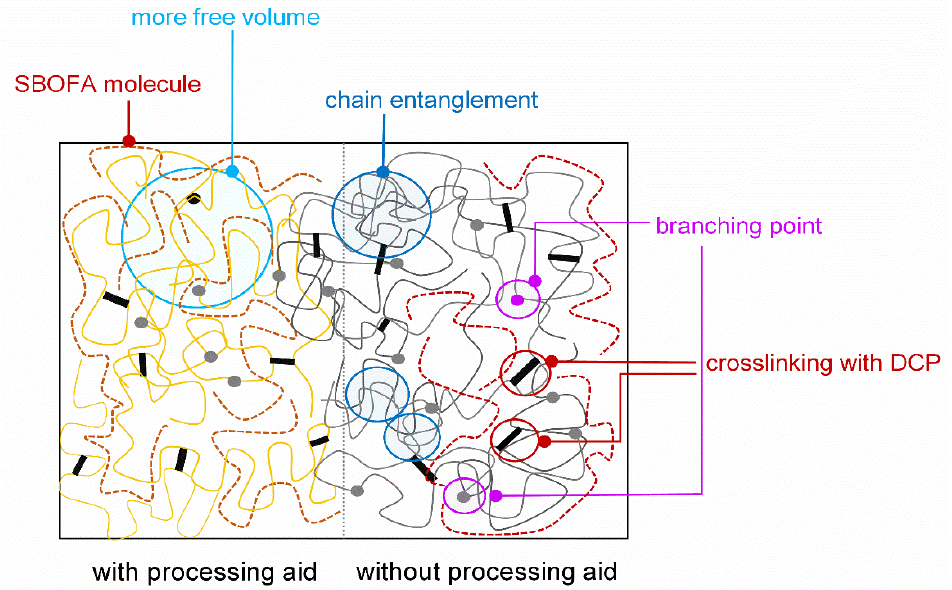
Figure 4. Proposed model for the plasticization with the SBOFA resulting in increasing free volume and chain mobility of the NBR compound.